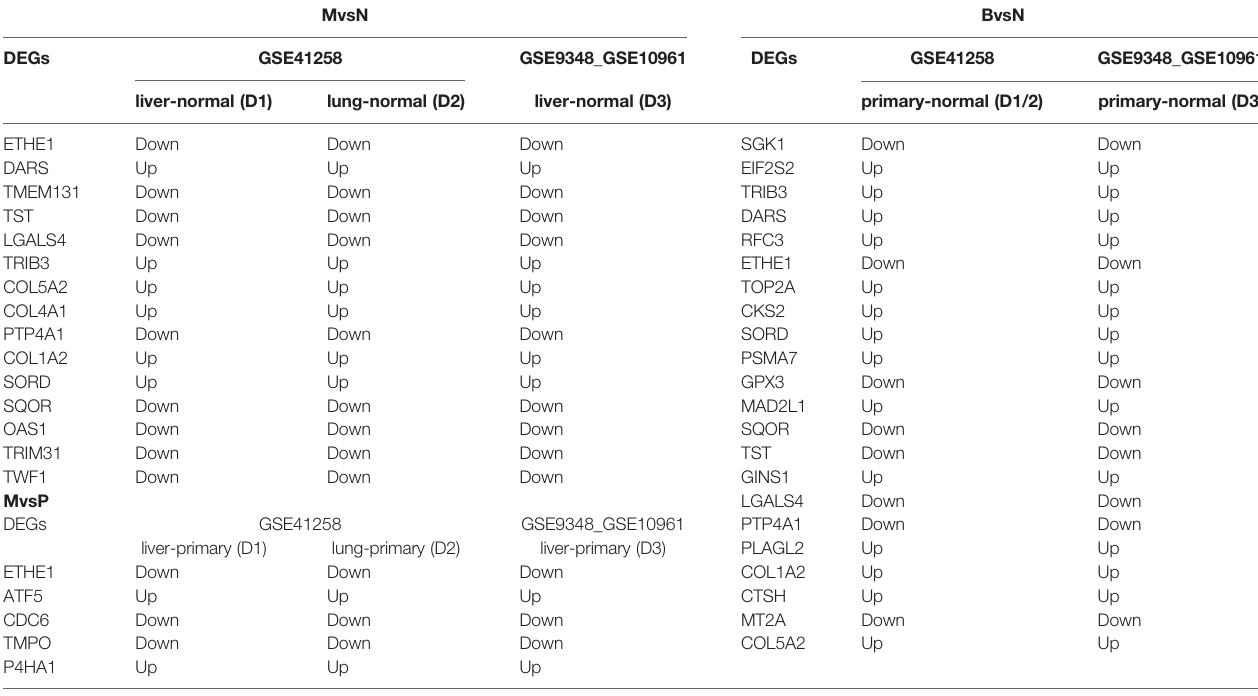
TABLE 1 | The practical information for the Core network DE genes in Test